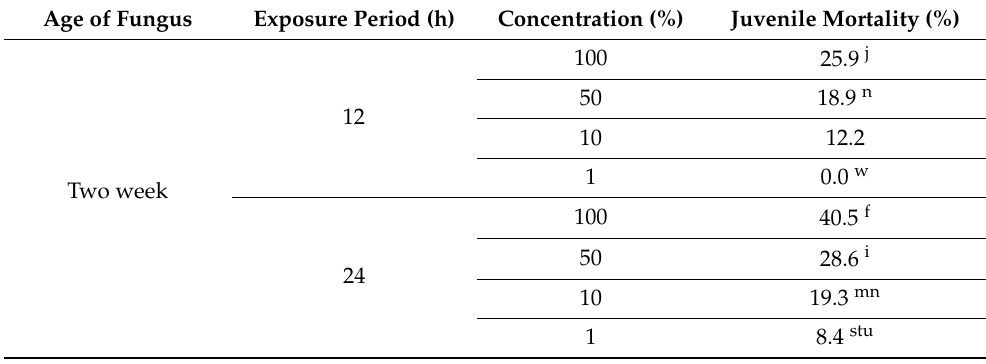
Effect of different stages of pileus of Ganoderma lucidum on juvenile mortality of Meloidogyne incognita